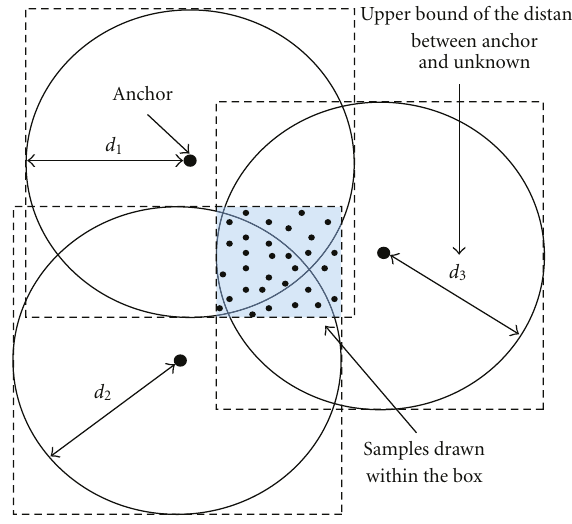
Figure 1: Drawing samples within the box that covers the region where anchors’ ranges